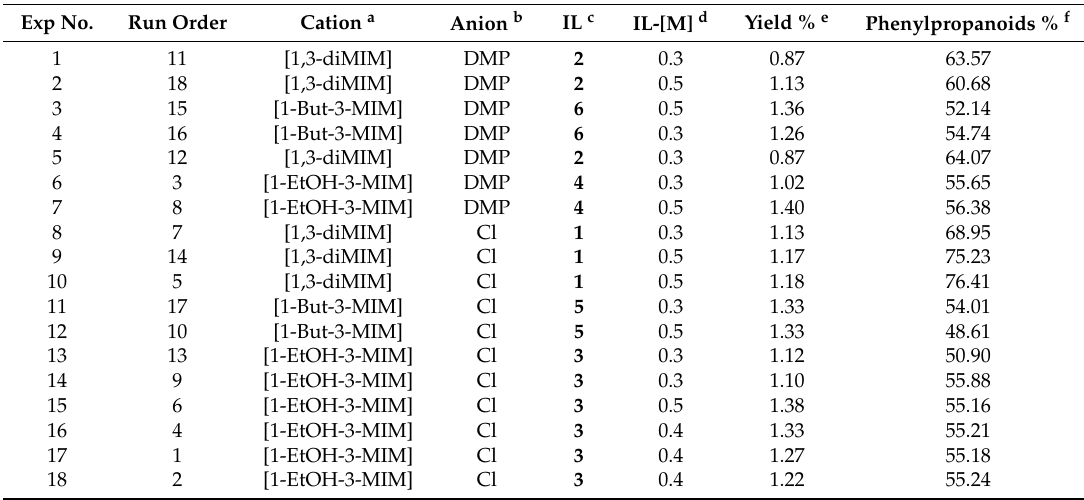
Table 1. Factor level and design matrix for extraction yield and phenylpropanoids percentage. Exp No.